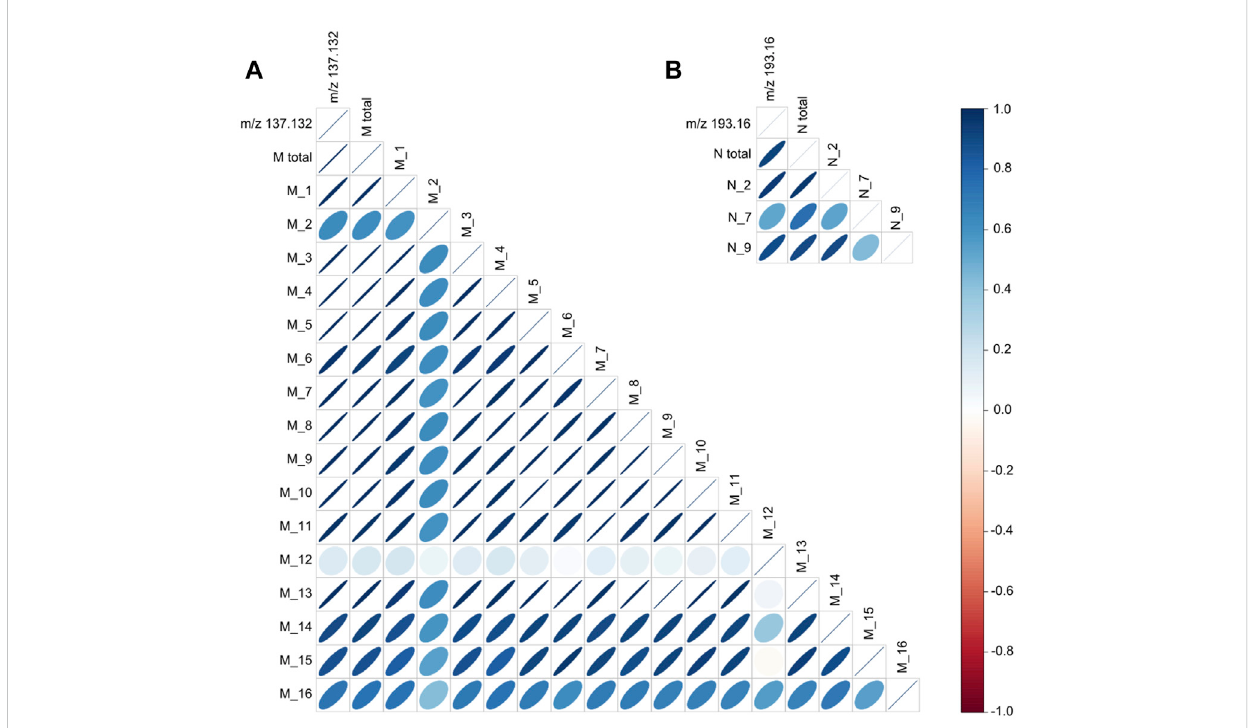
FIGURE 4 CorrelationanalysisofmonoterpenesandnorisoprenoidsassessedbyusingSPME/GC-MSandPTR-ToF-MS.Plot (A) reportsthecorrelationanalysis between the content of the main PTR-ToF-MS mass peak associated with monoterpenes ( m/z 137.132), the total amount of monoterpenes ( “ M total ” ), and the content of each monoterpene compounds (From M_1 to M_16) detected with SPME-GC-MS. Plot (B) reports the correlation analysis between the content of the main PTR-ToF-MS mass peak associated with norisoprenoids ( m/z 193.16), the total amount of norisoprenoids associated with this mass ( “ N total ” ), and the content of each norisoprenoid compounds associated with the mass peak m/z 193.16 (N_2, N_7, and N_9) detected with